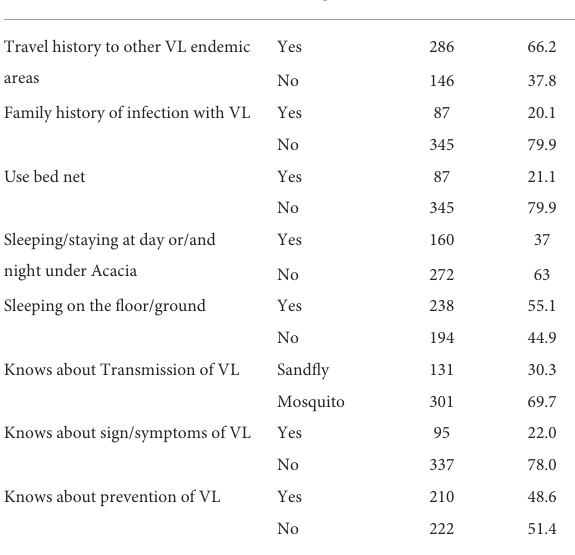
TABLE 3 Environmental, housing condition, and animal related factors among study participants of Dire District, Borena zone, Oromia Region, Ethiopia, 2021 ( n =